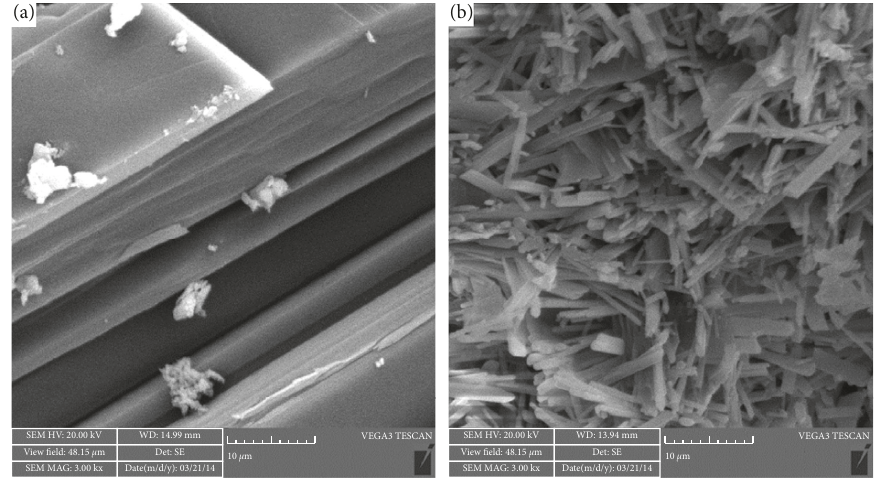
Figure 6: Microstructure of origin gypsum of POP and